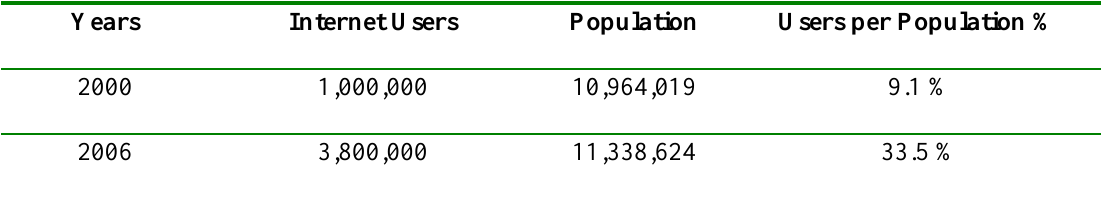
Table 2. Internet usage in Greece 2000, 2006 (Source Internet World Stats,